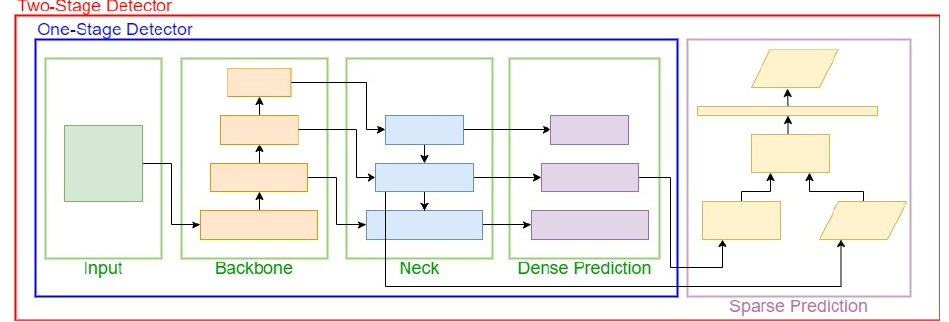
Figure 2. A visual comparison between a one-stage object detector vs. a two-stage object detector.